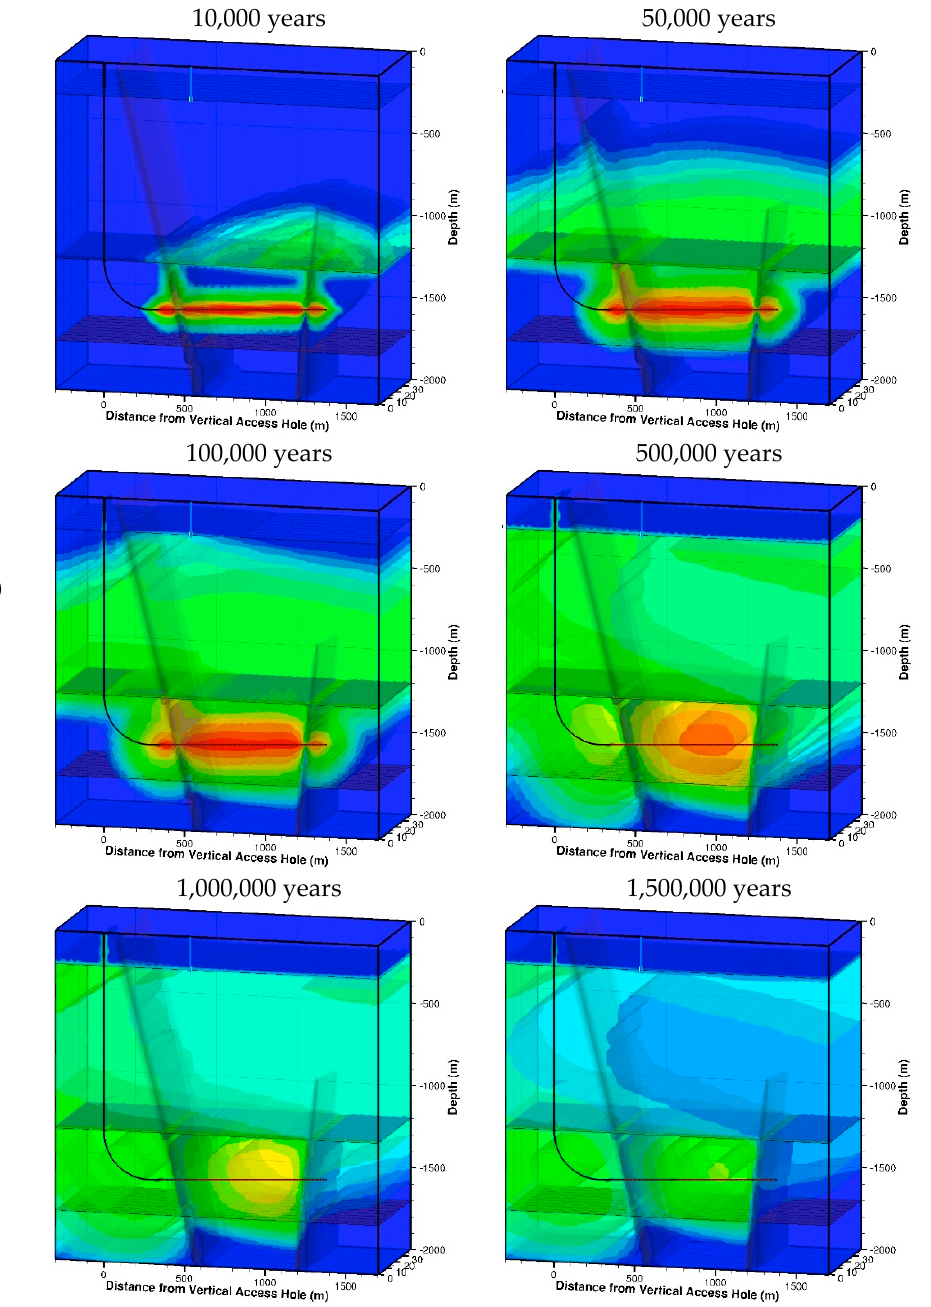
Figure 6. Distribution of 129 I activity at different times for a two-fault scenario with well-sealing backfill. However, these advective and diffusive rates of radial fluid and radionuclide losses become smaller with time, as pressure and concentration gradients decline. Moreover, as shown in Figures 7 and 8, the overpressured fault pushes contaminated water toward the vertical access hole. Consequently, the radial transport of water and radionuclides away from the access hole decreases, and the process is eventually reversed at higher elevations, where contaminated water emanating from the fault enters the access hole. Furthermore, the top of the access hole is slightly underpressured due to the continuous pumping from the drinking water well. As a result, while decreasing in the lower parts of the access hole, the vertical fluid flow and radionuclide transport increase again in the upper parts once the 129 I plumes migrating in the fault and overburden approach the